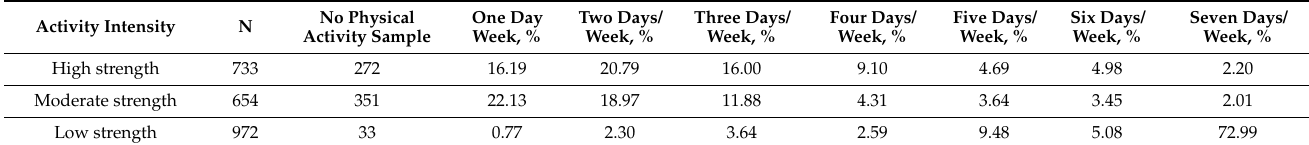
Table 3. Physical activity of university students.